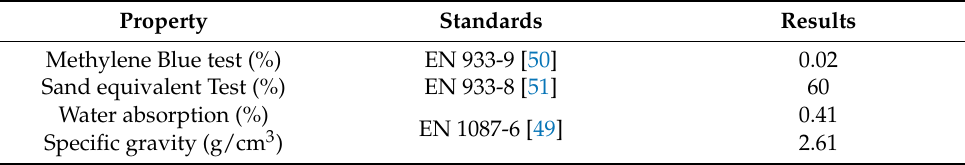
Table 5. Results for the fine aggregate characterization